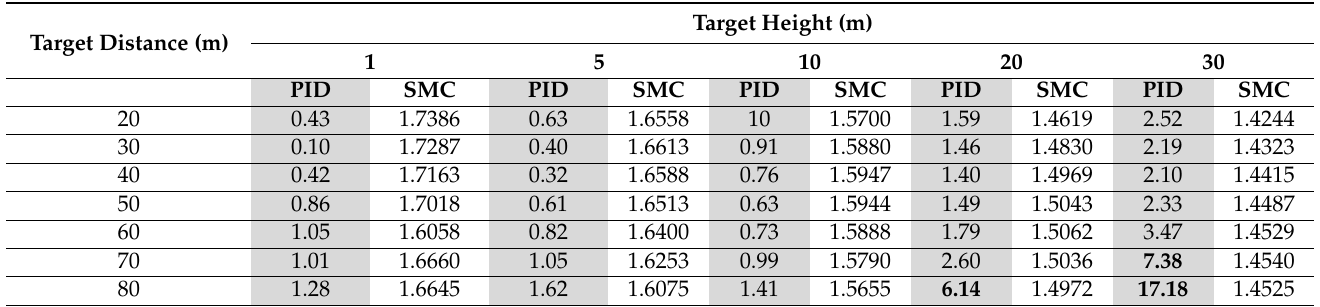
Table 8. Accuracy errors of shots fired from the firefighting robot at targets while making a right turn maneuver with PID and SMC.